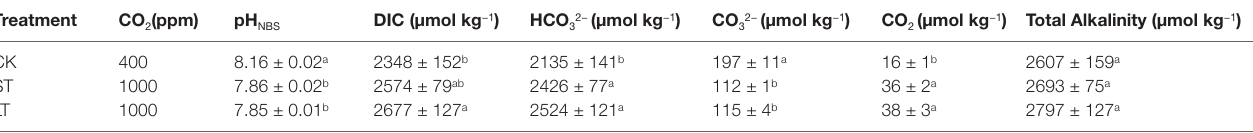
TABLE 1 | Parameters of the seawater carbonate system under CK, ST and LT treatments.